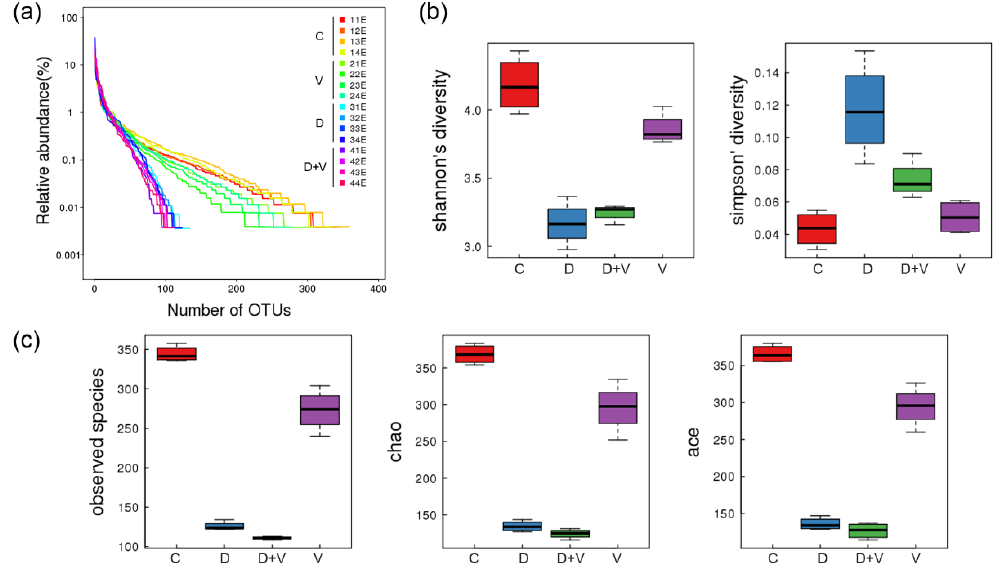
Figure 3. Diversity analysis. ( a ) OTU rank curve of each sample. The width of the x -axis in the chart displays the species richness, while the species evenness is derived from the slope of the line. A longer curve on the horizontal axis means the species is more abundant in the sample. A flatter curve indicates that the species composition of the sample is more homogeneous. The smoothness of the curve shows the diversity of the sample. A smooth curve indicates a sample with high diversity, while a rapidly descending curve implies a high proportion of dominant bacteria and low diversity. ( b ) Boxplots of the Shannon and Simpson indexes of alpha diversity indexes among groups to reflect the species diversity of the community. ( c ) Boxplots of the observed species, Chao, and Ace indexes of alpha diversity indexes among groups to reflect the species richness of community. The complexity of the sample is proportional to the observed species, Chao, Ace, and Shannon indexes, with a negative correlation with the Simpson value. When the species richness is the same, the greater the species evenness, and the greater the community diversity will be. Group designations were as follows: control (C); virus infection model (V); dysbacteriosis model (D); dysbacteriosis and virus infection (D + V).